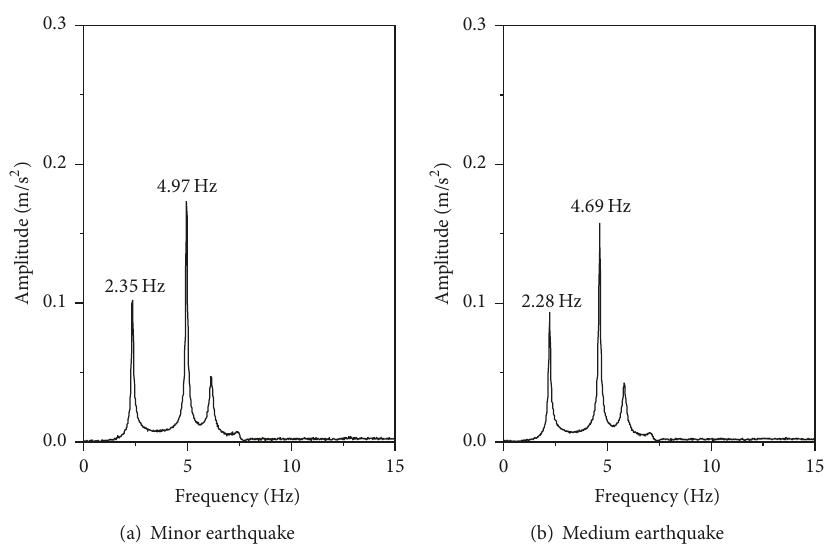
Figure 11: Variation characteristics of the ES subsystem during the minor and medium earthquakes.